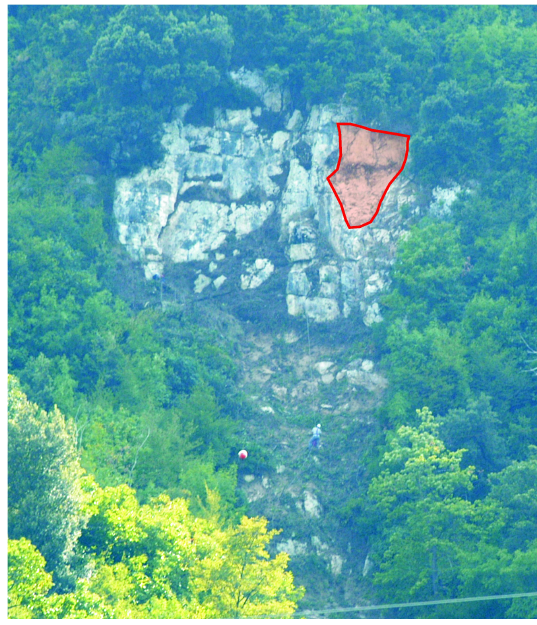
Fig. 6. Release area of the 10 January 2003